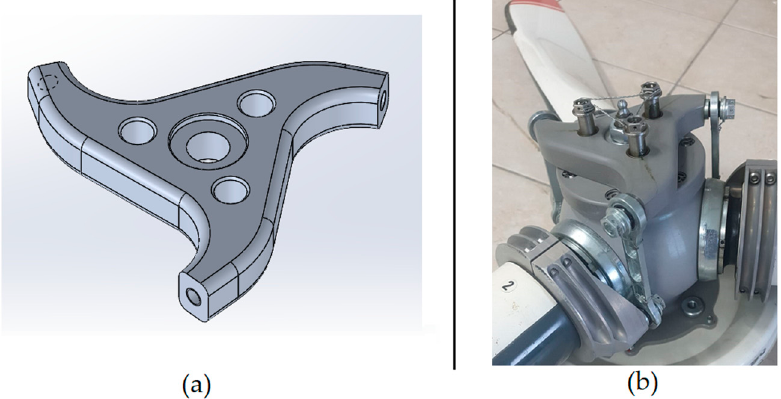
Figure 7. ( a ) 3D CAD model of the Propeller Pitch Controller (PPC); ( b ) Real part assembled with the blades.